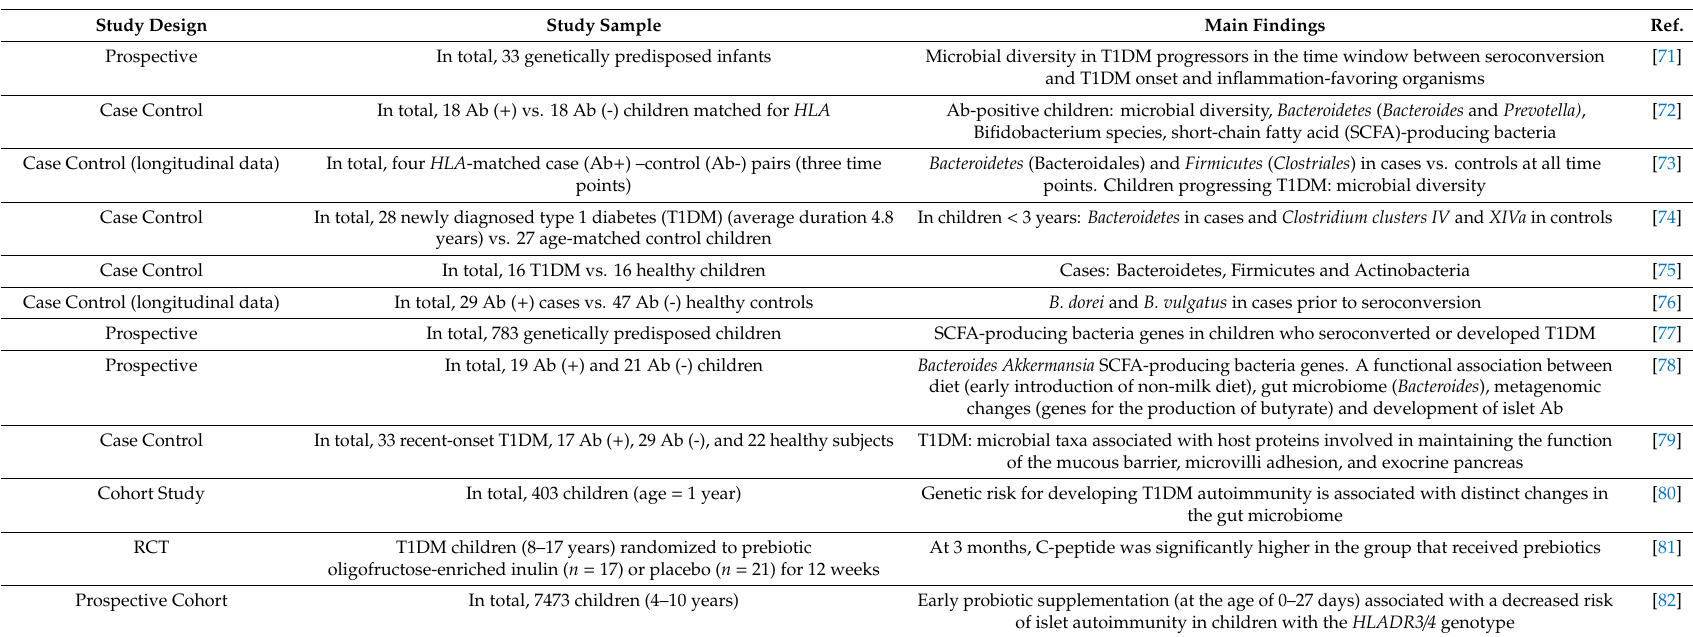
Table 1. Type 1 Diabetes and the Microbiota: Human